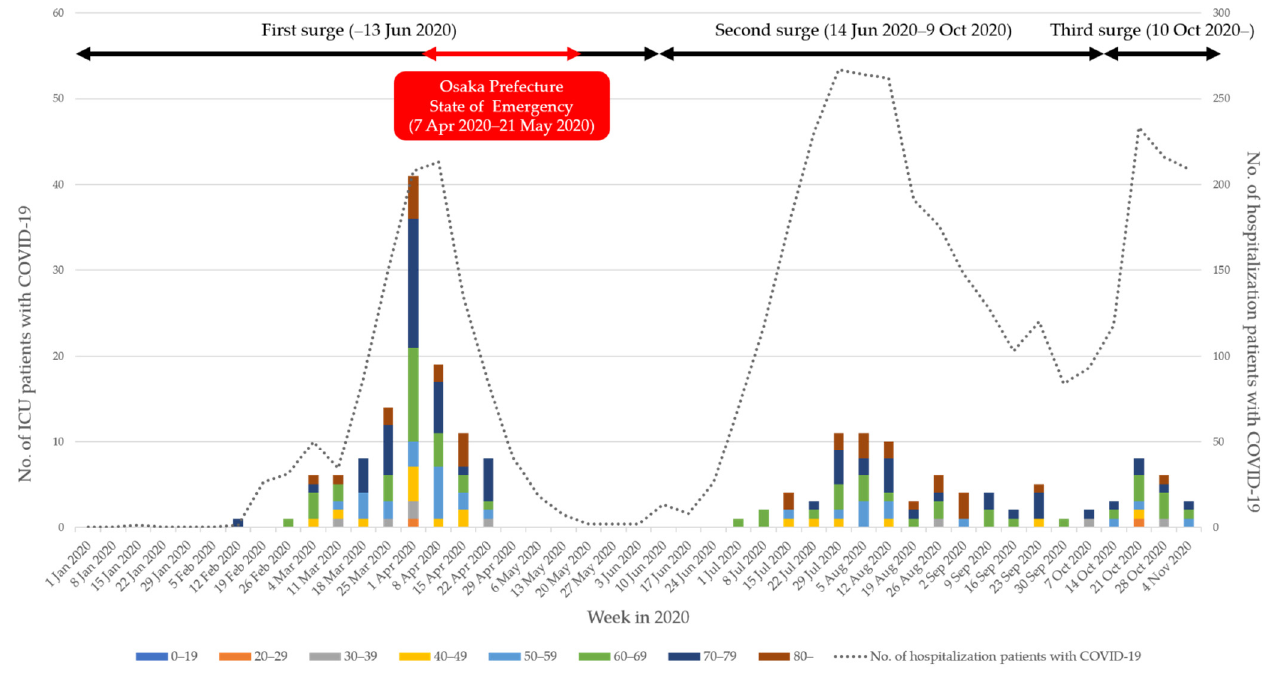
Figure 2. Weekly count of intensive care unit patients with COVID-19 per age group in Osaka, Japan.